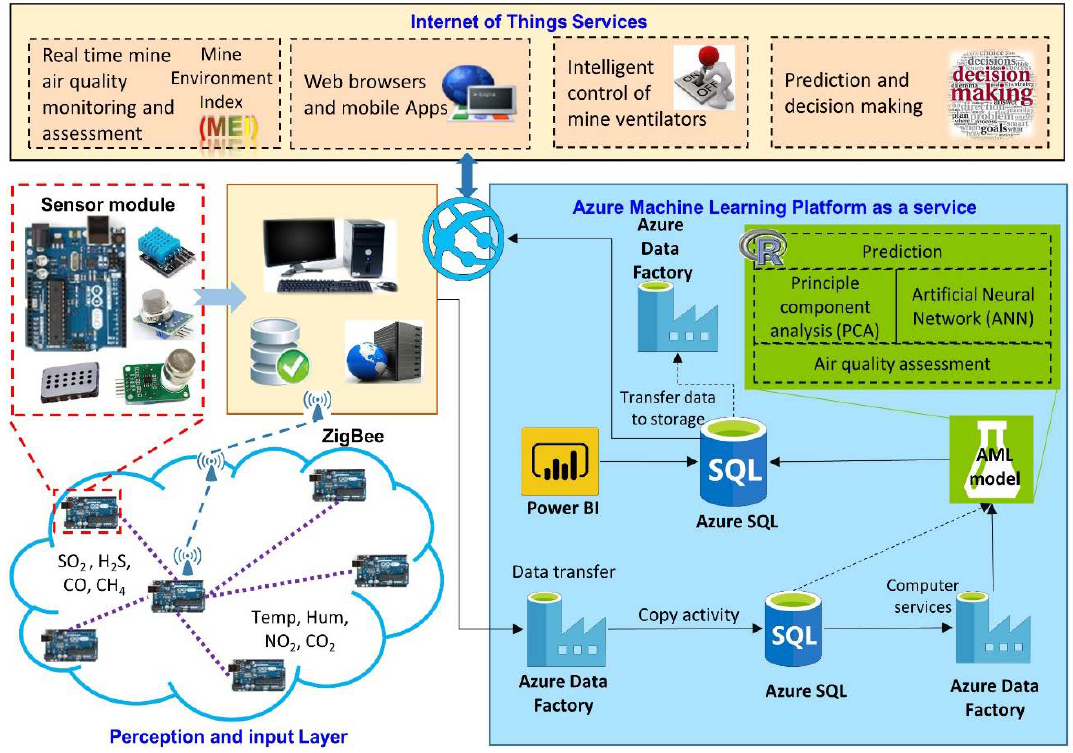
Figure 1. System Architecture comprising Arduino as a microcontroller for air quality monitoring in mines, based on Azure Machine Learning (AML), for air quality prediction.